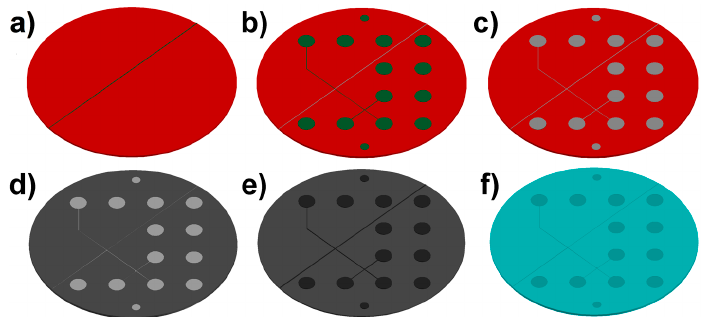
Figure 6. Fabrication process of the microfluidic polymer chip: ( a ) Si wafer oxidation and UV lithography for the opening of the groove for the embedding of optical fibers; ( b ) Wet etching of the oxide layer in yellow-light environment and aligned lithography (on the same resist previously used) for the patterning of the microfluidics; ( c ) Deep reactive ion etching (DRIE) of the groove for optical fibers, dry etching of the oxide in the microfluidic area and DRIE of both the microfluidic channel and the groove; ( d ) Resist stripping and NiV sputterning; ( e ) Ni electroplating and Si wafer removal in KOH; ( f ) Injection molding of CoC polymer.